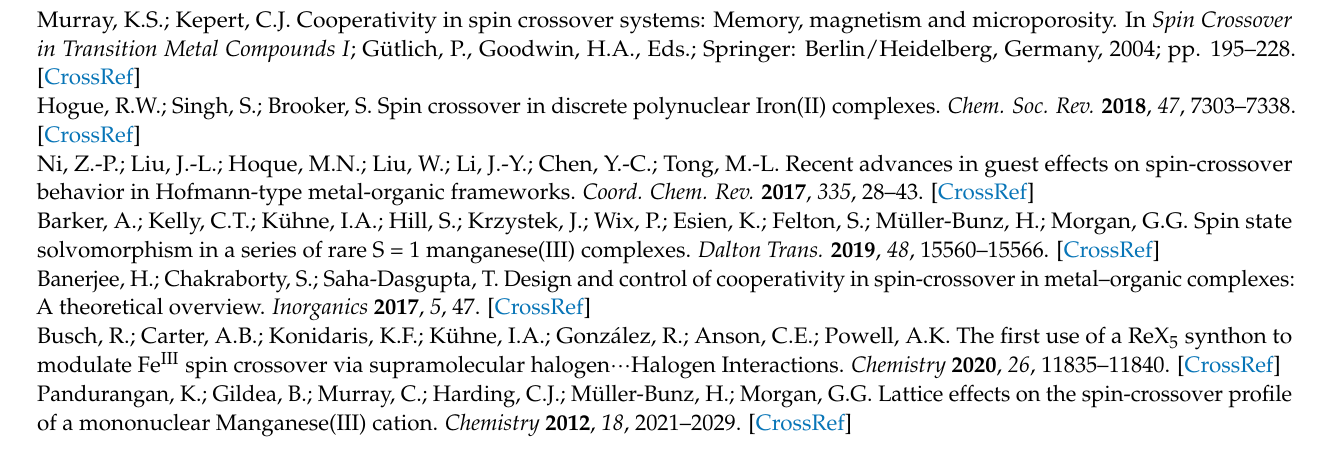
the a-axis, Table S1: Crystallographic details for compounds 1 – 3 , Table S2: Crystallographic details for compounds 4 & 5 , Table S3: Crystallographic details for compounds 6 & 7 , Table S4: Crystallographic details for compounds 10 – 12 , Table S5: Raman vibration modes of complexes ( 10 )–( 12 ) collected at room